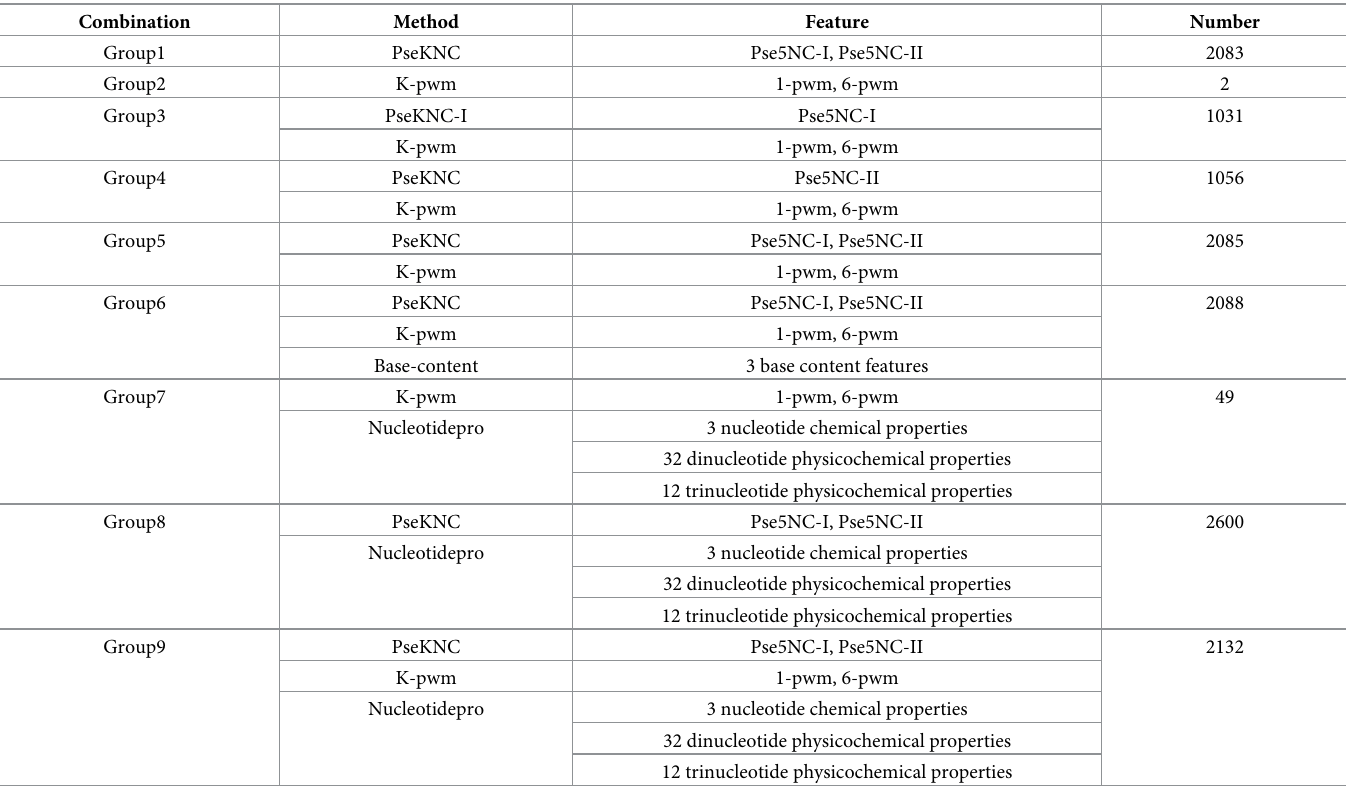
Table 5. Combination of feature extraction methods.